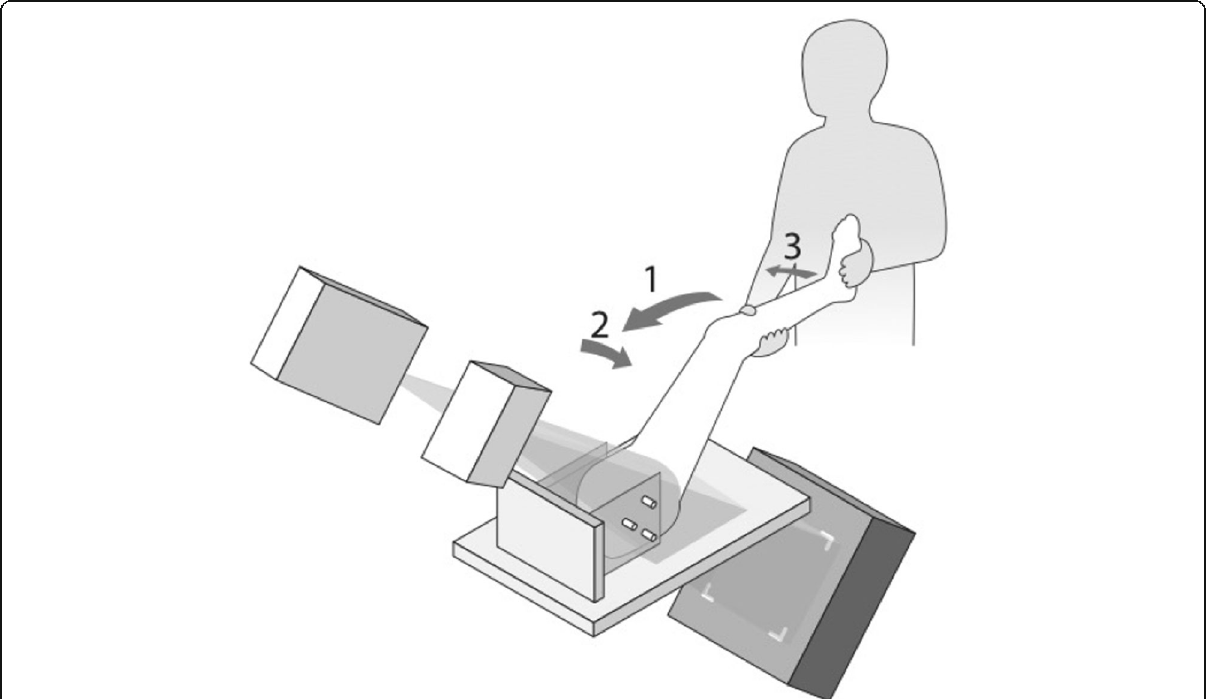
Leiden, the Netherlands) was placed in a 45° angle to the horizontal plane (Fig. 1). The two image detectors (Canon CXDI-50RF) were slotted in the calibration box. Source